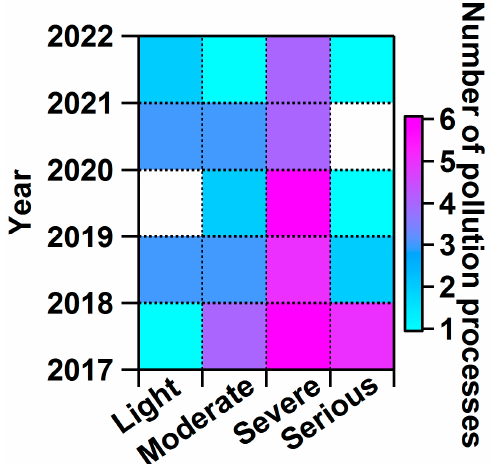
Figure 2. Annual evolution of the number of different PM 2.5 pollution level processes from 2017 to 2021.